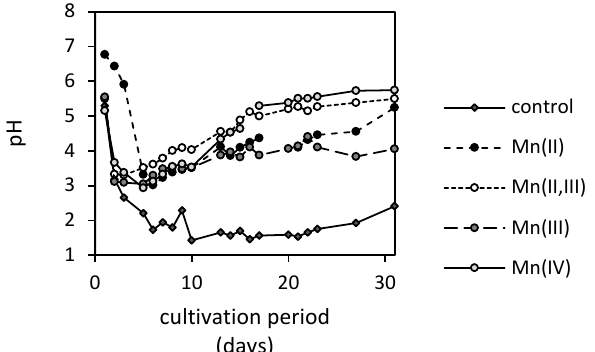
Figure 8. Changes in pH of culture medium supplemented with various manganese oxides (MnO, MnO · Mn 2 O 3 , Mn 2 O 3 and MnO 2 ) incubated in the presence of Aspergillus niger for 31 days (control is a manganese-free treatment).